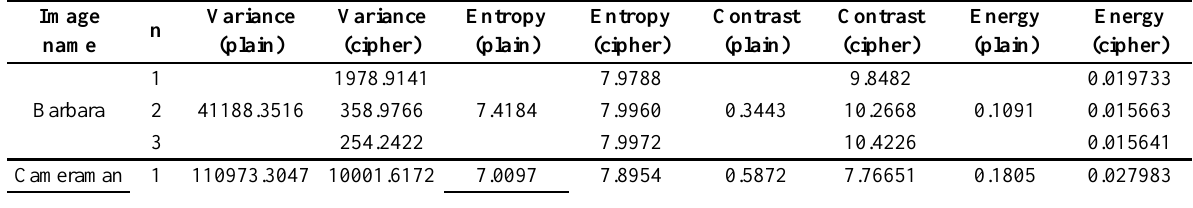
Table 3. The variance, entropy, contrast and energy analysis of the proposed